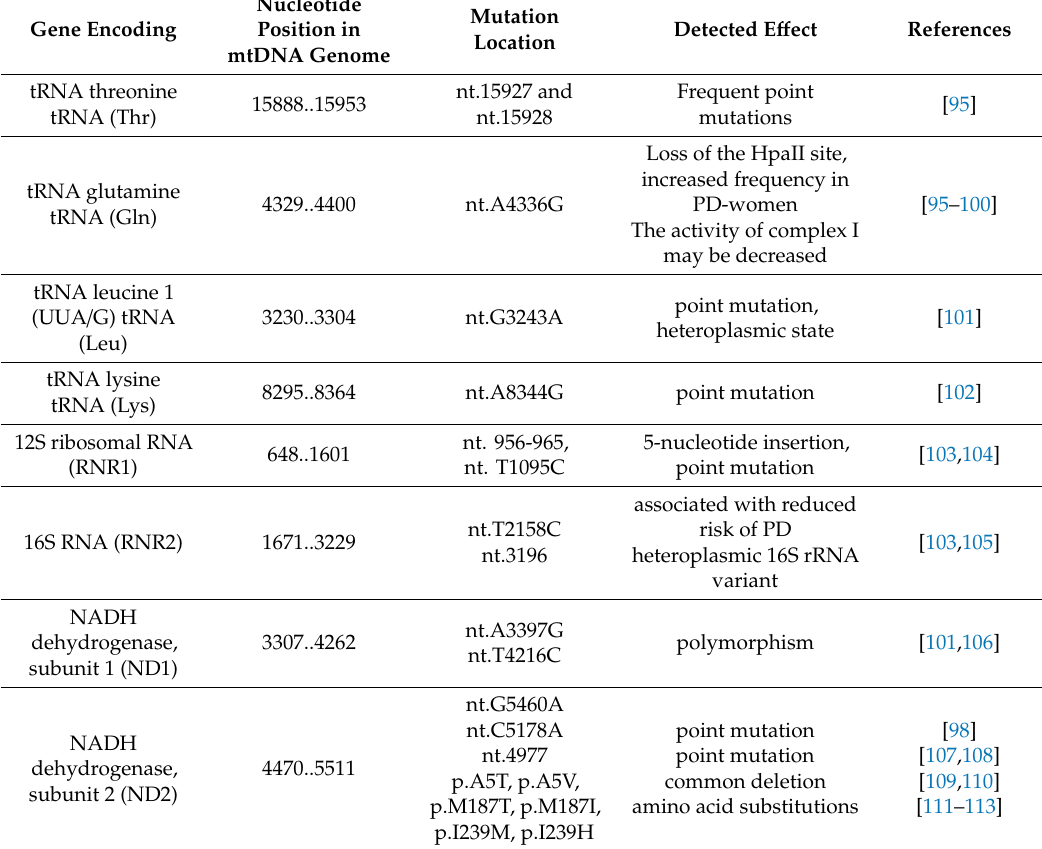
Table 2. Mitochondrial DNA (mtDNA) mutations associated with Parkinson’s disease (PD). Gene